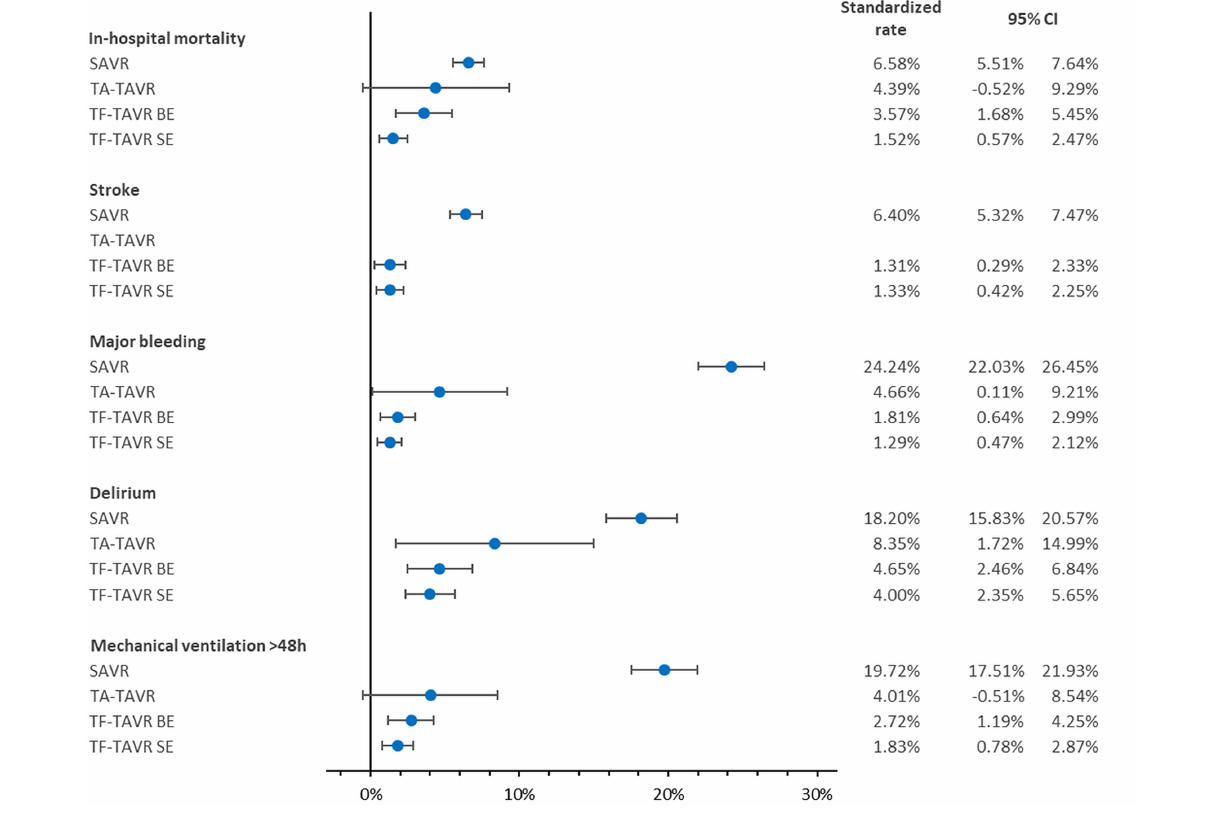
FIGURE 3 Standardized rates of in-hospital outcomes of patients treated for aortic regurgitation between 2018 and 2020 in Germany. BE, balloon-expandable; CI, con fi dence interval; SAVR, surgical aortic valve replacement; SE, self-expanding; TA, transapical; TAVR, transcatheter aortic valve replacement; TF, transfemoral. Values of stroke in TA-TAVR could not be calculated due to a stroke rate of 0.00% in